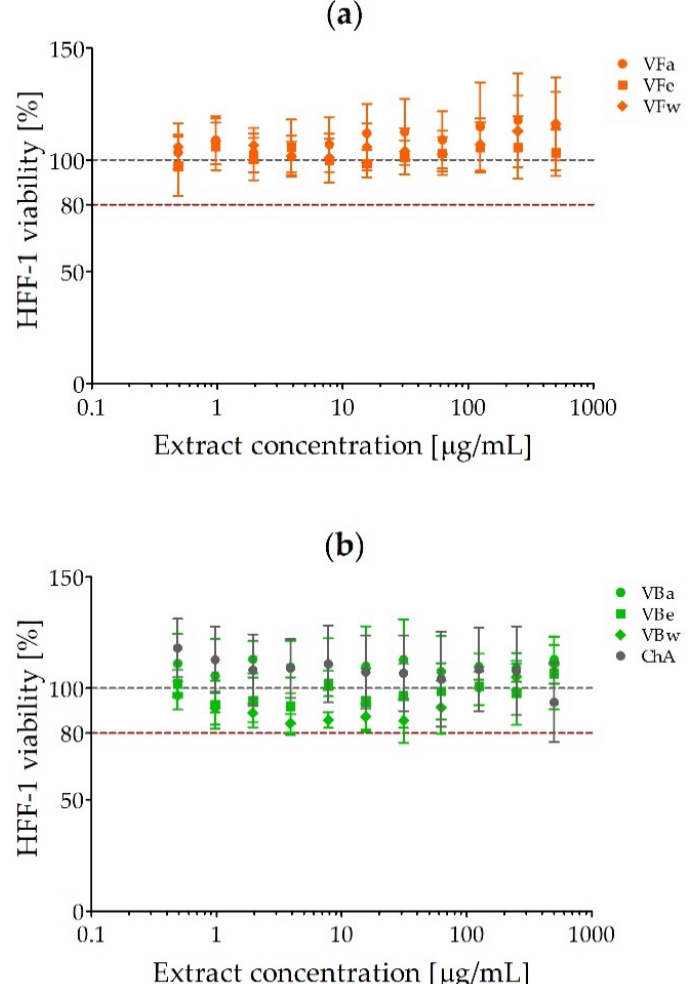
Figure 1. The cytotoxic activity of V. opulus extracts on the human foreskin fibroblast line HFF-1: ( a ) V. opulus fruit extracts (VF); ( b ) V. opulus bark extracts (VB); a/e/w—acetonic/ethanolic/water extract; ChA—chlorogenic acid.